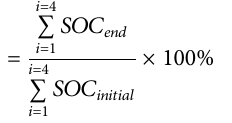
Frontiers in Energy Research |